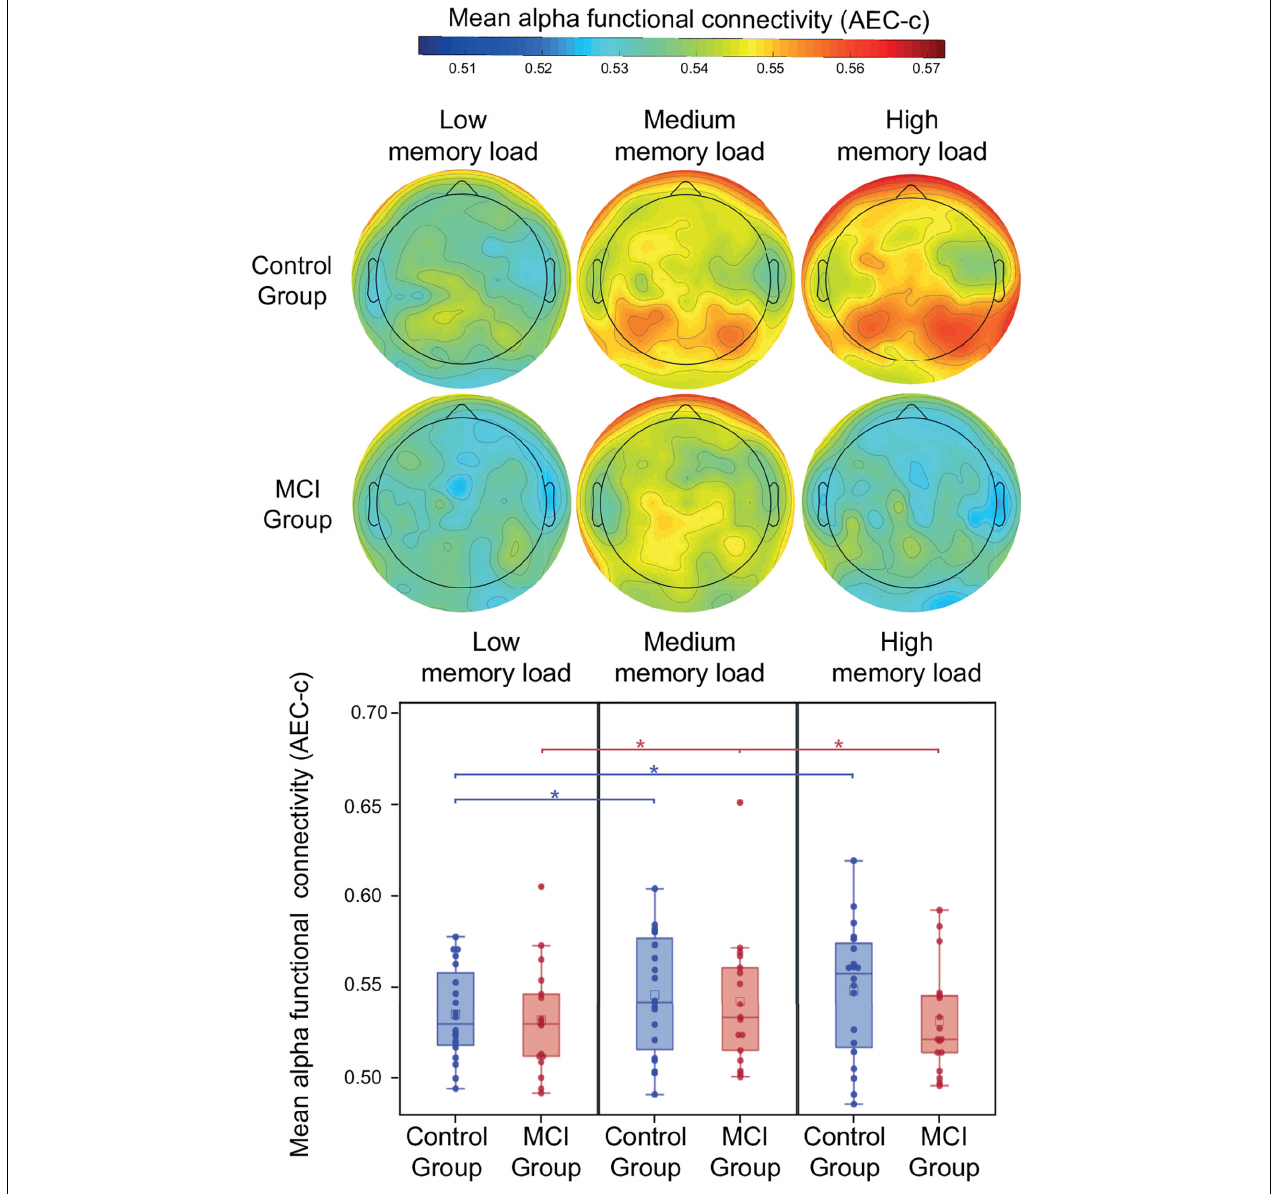
FIGURE 3 | Mean alpha AEC-c in the retention condition of the PAL test. Functional connectivity in the alpha frequency band (measured by AEC-c) during the retention period of the PAL test and topographical representation of the mean AEC-c values of EEG electrodes (i.e., the average functional connectivity strength to all other electrodes). * p <